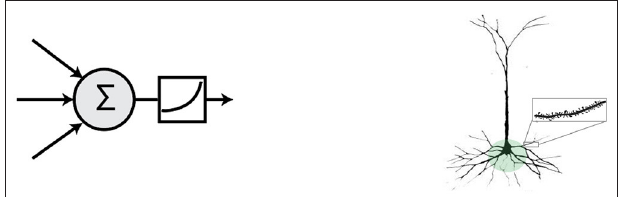
FIGURE 1 | (Left) The point neuron prevalent in most ANNs today computes a simple linear weighted sum of its inputs followed by a non-linearity. (Right) Morphology of a representative pyramidal neuron. Pyramidal cells in the brain exhibit a vastly more complex structure and functionality. Inset shows a prototypical basal dendritic segment that acts as an independent computational